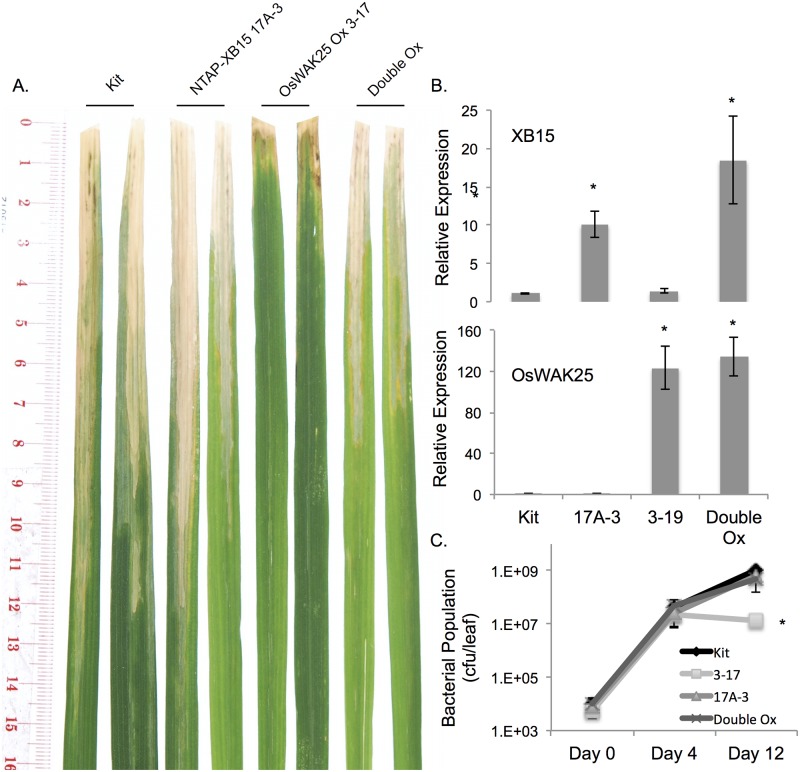
Overexpression of XB15 compromises OsWAK25-mediated resistance to Xoo.Transgenic lines NTAP-XB15 Ox 17A-3 and OsWAK25 Ox 3–17, both in the Kitaake background, were crossed and segregating F2 progeny of the double overexpression line were inoculated with Xoo strain PXO99 along with Kitaake and parental lines as controls. (A) Photos were taken 14 dpi. (B) Leaf tissue for RNA extraction was collected from 4-week old plants. Y-axes on the graphs indicate fold change from Kitaake. CT values were first normalized to ubiquitin as an internal control followed by normalization to Kitaake. Each bar represents the average and standard error of 3 sibling plants. Asterisks represent statistical significance using Student’s t-test, p < 0.001. (C) Each time point represents the average and standard error of three sibling plants of three technical replicates each. The asterisk indicates statistical significance with Student’s t-test, p < 0.001. Each experiment was conducted three times with similarly significant results. See Fig 8 for segregation and lesion length data for F2 progeny.